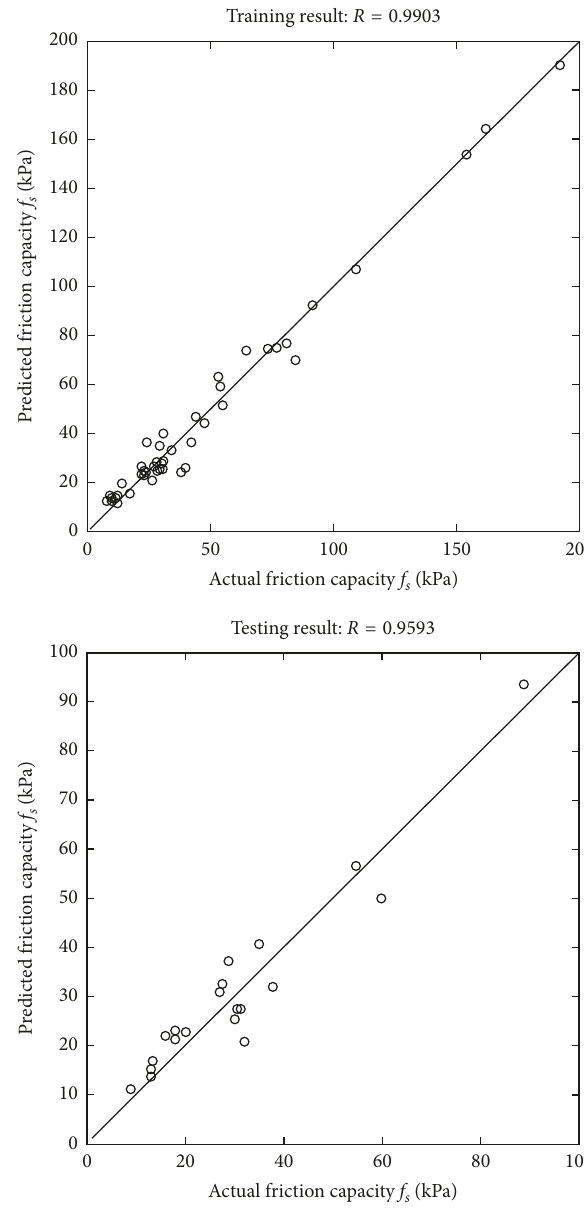
Figure 5: Obtained results of the ST-LSSVM predictive model for both training and testing